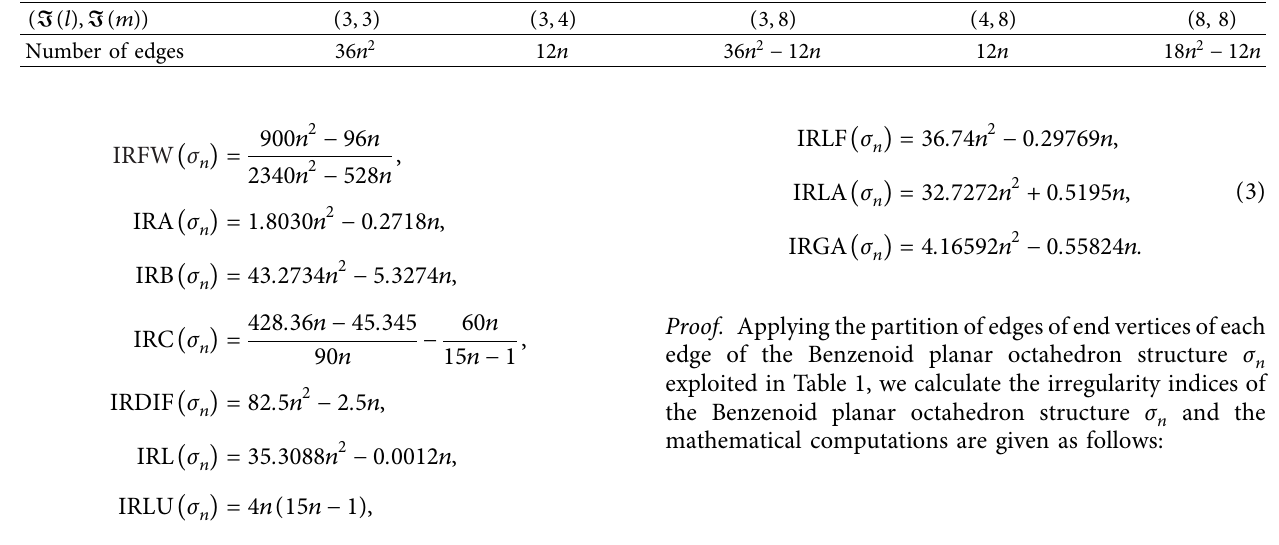
Figure 1: Benzenoid planar octahedron structure of dimension 2. Table 1: Edge partition of benzenoid planar octahedron